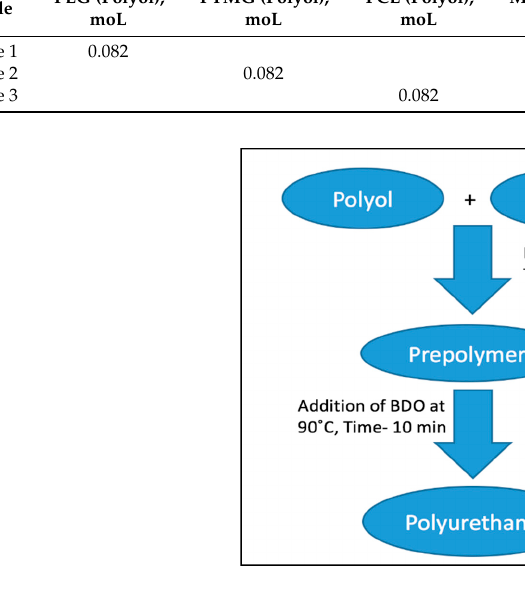
Table 1. Concentration details of polyurethane synthesis.